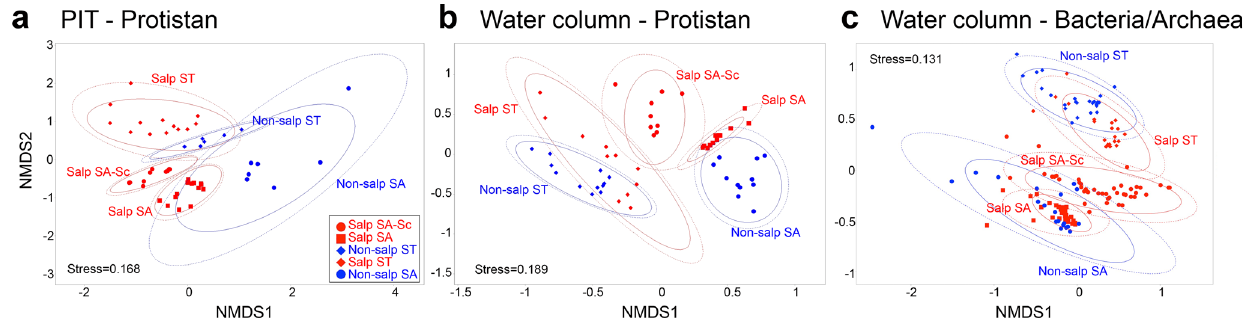
Fig.7|Non-metricmultidimensionalscaling(NMDS)ofmicrobialcommunities during SalpPOOP. a Protistan communities sampled in Particle Interceptor Traps (PIT), b Protistan communities in the euphotic zone of the water column (WC) sampled from the conductivity – temperature-depth CTD rosette, and c Bacteria/ Archaeacommunitiesintheeuphoticzoneofthewatercolumn(alsosampledfrom the CTD). Water mass explained most of the variance among communities in the